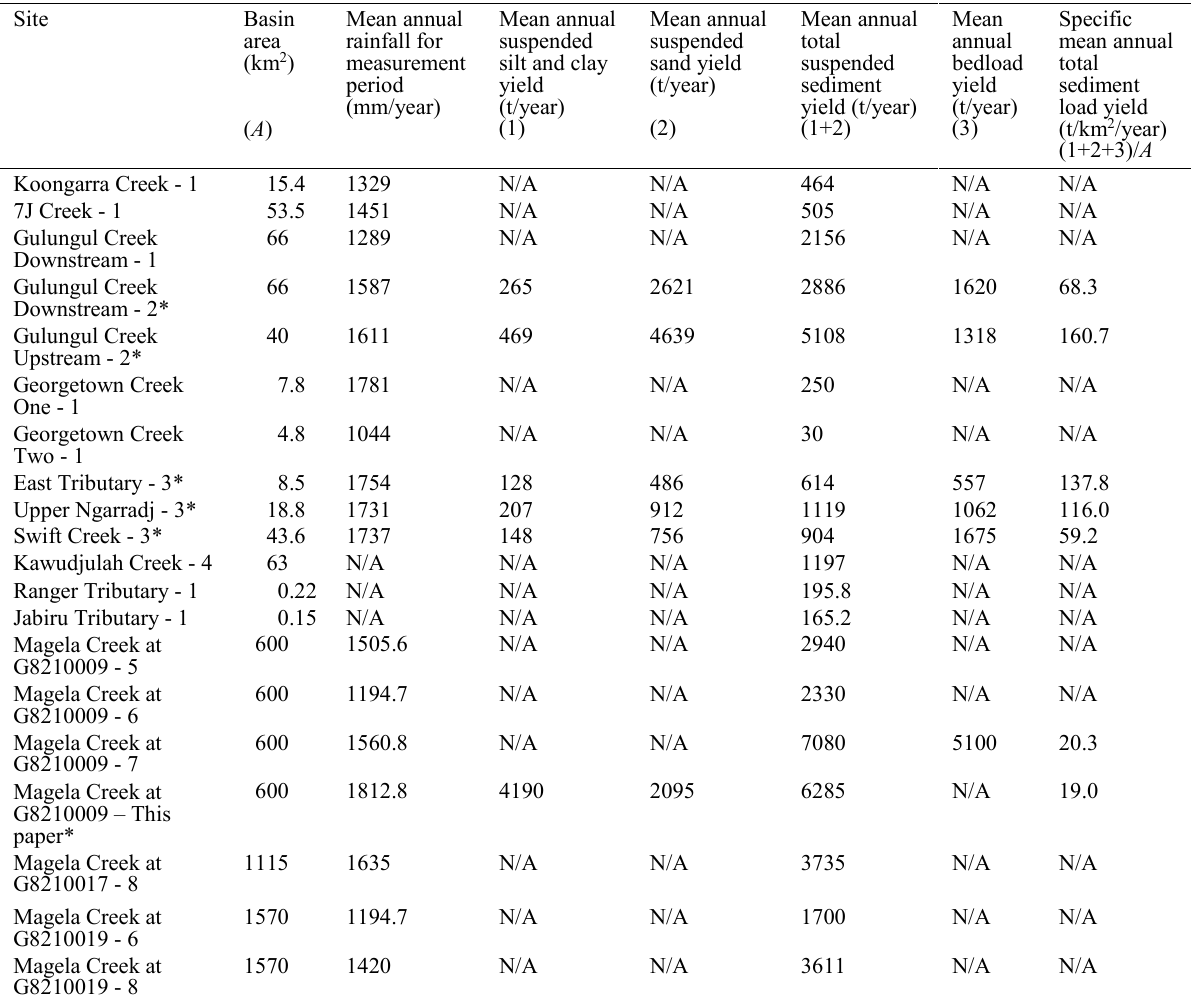
Table 1 Measured sediment yields in the Alligator Rivers